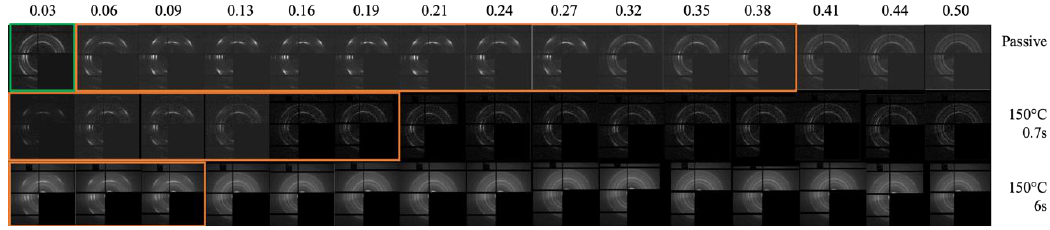
Figure 10. WAXS scattering distribution of the passive, A, and B moldings at different distances from one sample surface (the normalized distance is reported in the topmost of the figure). The higher orientation regions are delimited by orange borders, whereas the region with poor orientation (close to the surface of the passive sample) is delimited with the green borders.